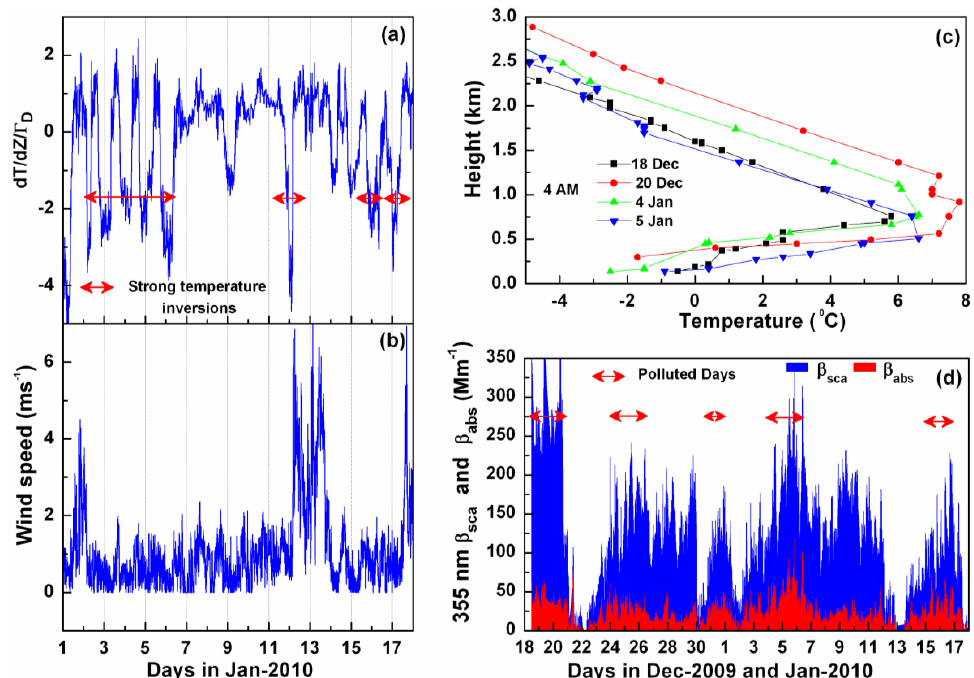
Fig. 3. Meteorology and aerosol optics measurements at 355nm during winter 2009/2010 at Reno, Nevada. (a) Temperature gradient normalized to dry adiabatic lapse rate ( − 9.8 ◦ C), with negative values indicating temperature inversions, (b) wind speed, (c) temperature profiles from radiosonde launches, whereas the height is above the ground level (a.g.l.). Strong temperature inversions are associated with the highly polluted events of the winter season, (d) two minute average of the ambient aerosol scattering and absorption coefficients.